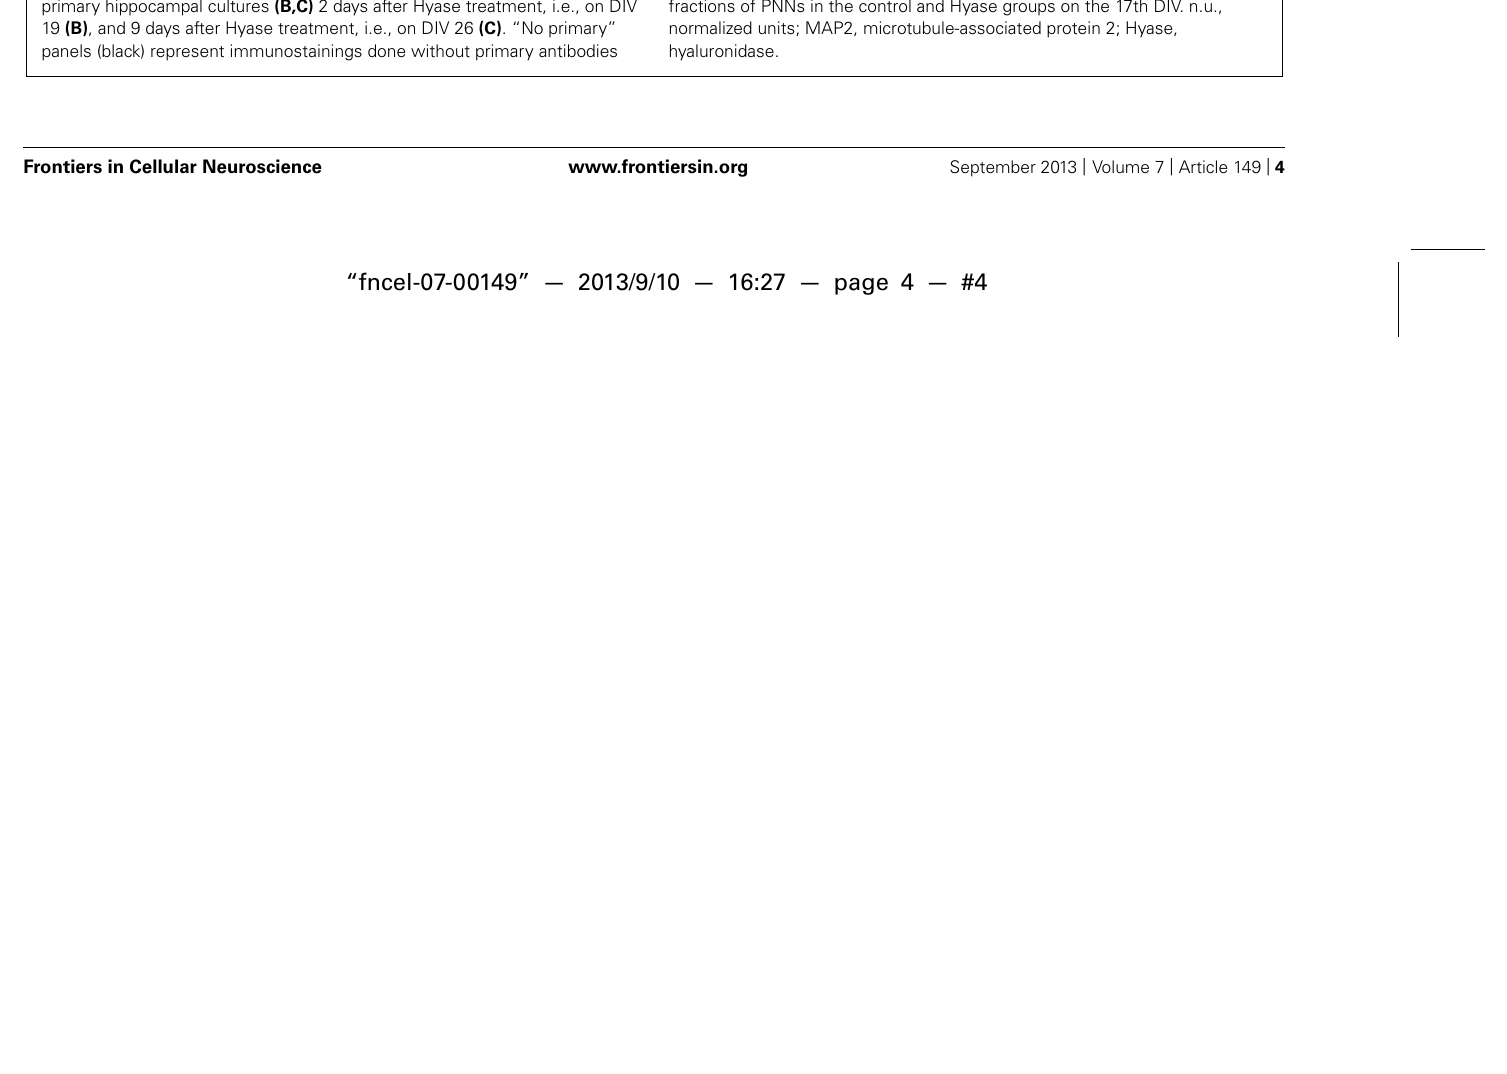
FIGURE 2 |The effect of hyaluronidase on PNNs in the primary hippocampal cultures (A–C) . PNNs, stained by aggrecan antibodies (yellow), envelop hippocampal cultured neurons, which were labeled by MAP2 antibodies (red). Hippocampal neurons in the control (A) and Hyase-treated primary hippocampal cultures (B,C) 2 days after Hyase treatment, i.e., on DIV 19 (B) , and 9 days after Hyase treatment, i.e., on DIV 26 (C) . “No primary” panels (black) represent immunostainings done without primary antibodies